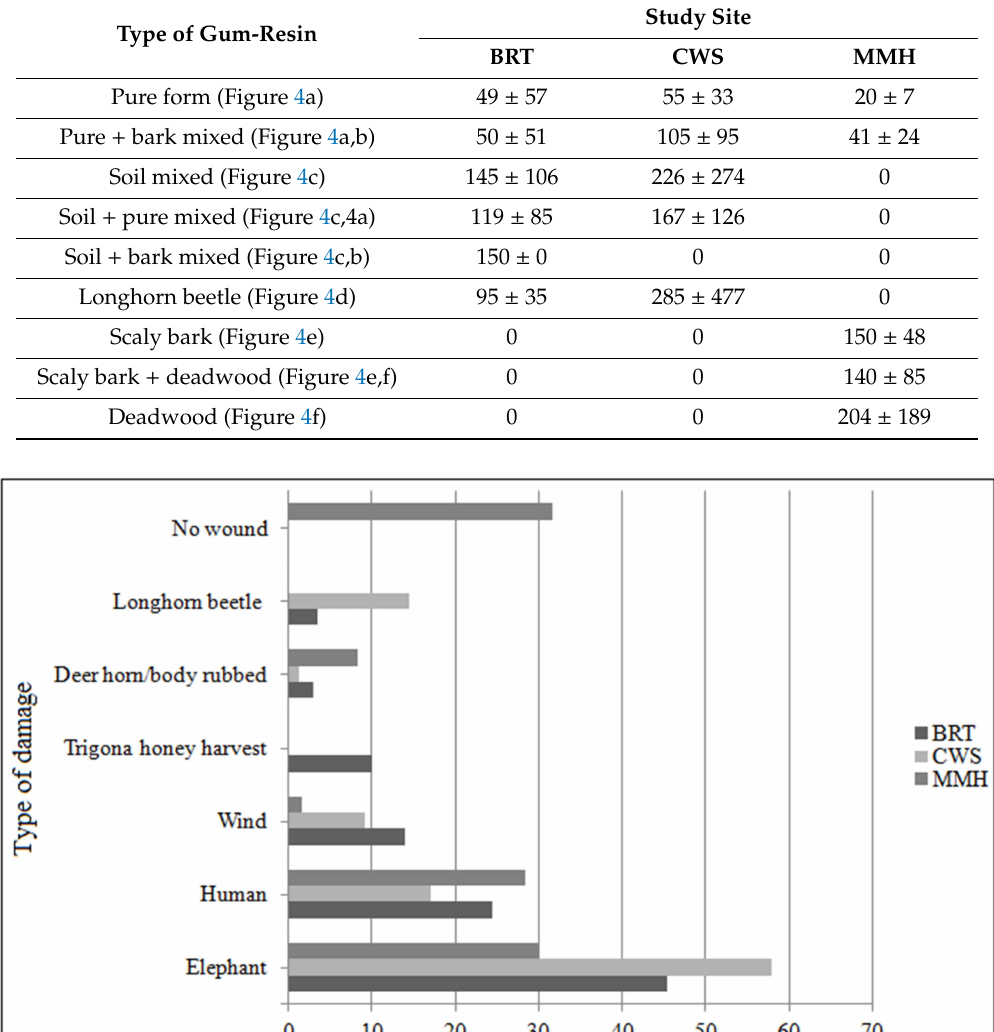
Table 2. Weight (g) of gum-resin harvested from a single tree during harvest trips.